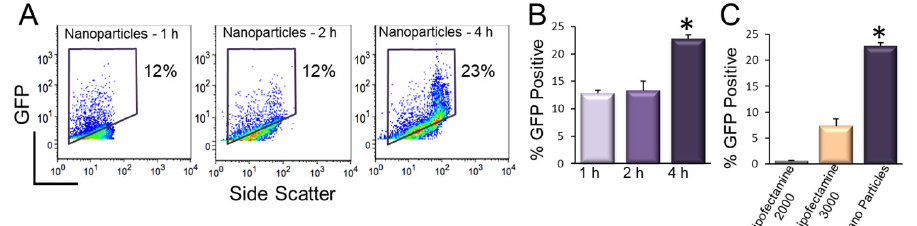
Figure 8. Incubation time-dependent transfection efficiency using magnetic nanoparticles [78]. ( A ). Flow cytometric analysis of pIRES2-EGFP-transfected hiPSCs using 1, 2, and 4 h of magnetofection. ( B ). Summary data from A (* p < 0.05, n = 3 − 7). ( C ). Comparison of the transfection efficiency of hiPSCs using pIRES2-EGFP vector and lipofectamine-2000, -3000 and nanoparticle-mediated transfections. Four hours of transfection was used for all the conditions (* p < 0.05, n = 3 − 7).